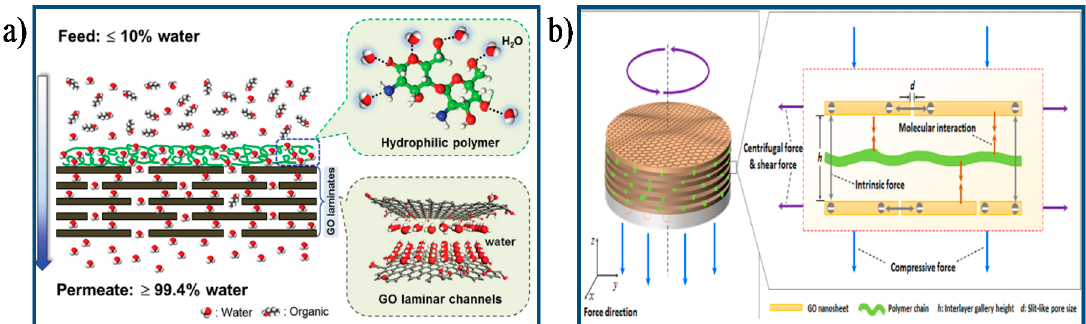
Figure 9. Schematic diagram of the process for improving separation performance of GO membranes: ( a ) Schematic illustration of the integrated GO membrane combined an ultrathin surface water-capturing polymeric layer with GO layers [116]. Copyright 2015 John Wiley and Sons; ( b ) Schematic illustration of the process to tune 2D channels of GO membrane with external force [55]. Copyright 2016 American Chemistry Society.